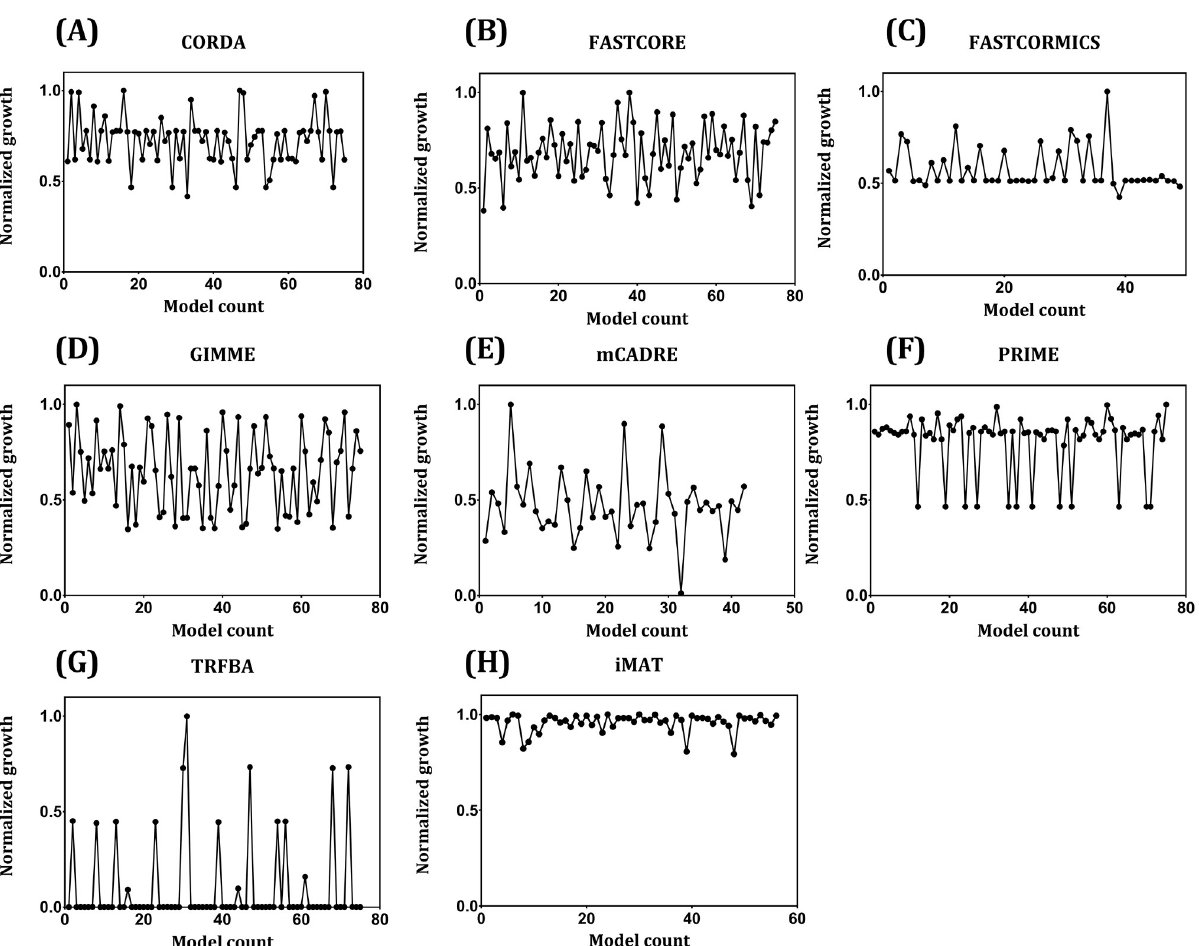
Fig 8. Normalized growth prediction of GEMs generated using data from repeated 5-fold cross-validation. (A) CORDA, (B) FASTCORE, (C) FASTCORMICS, (D) GIMME, (E) mCADRE, (F) PRIME, (G) TRFBA, (H) iMAT. Only algorithms capable of predicting growth are shown. For each algorithm, “model count” represents the GEMs generated by incomplete expression data or core reactions set in the input. For a better comparison, growth rates were normalized to the maximum value.